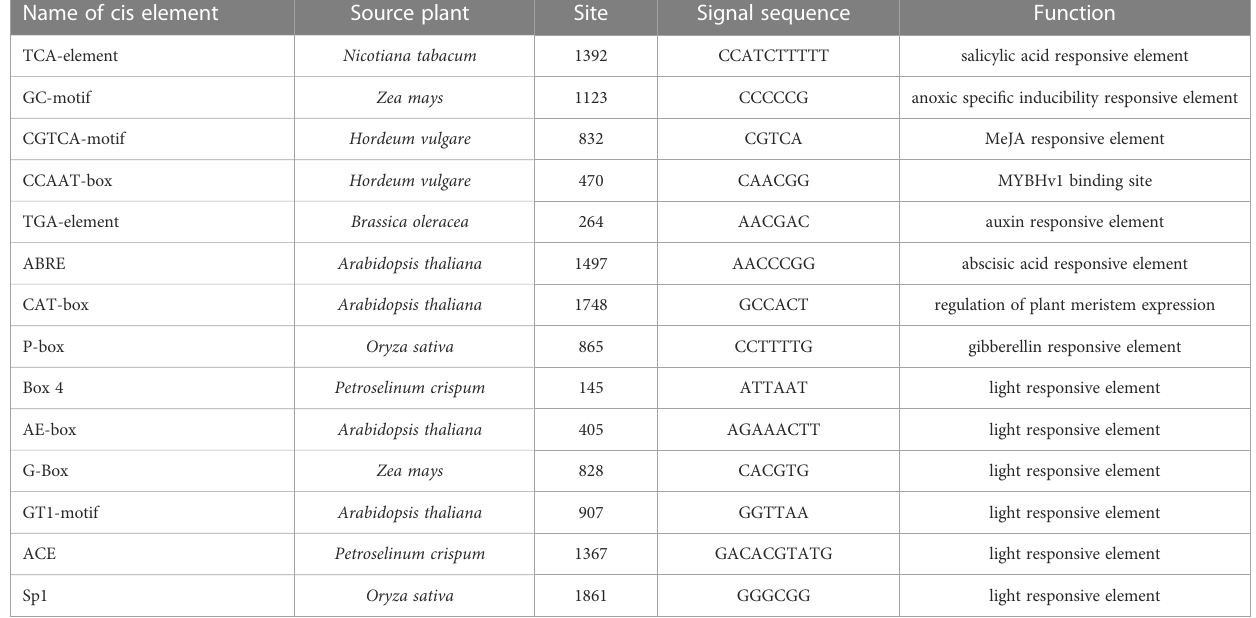
TABLE 1 ZmHOX32 gene promoter cis -acting